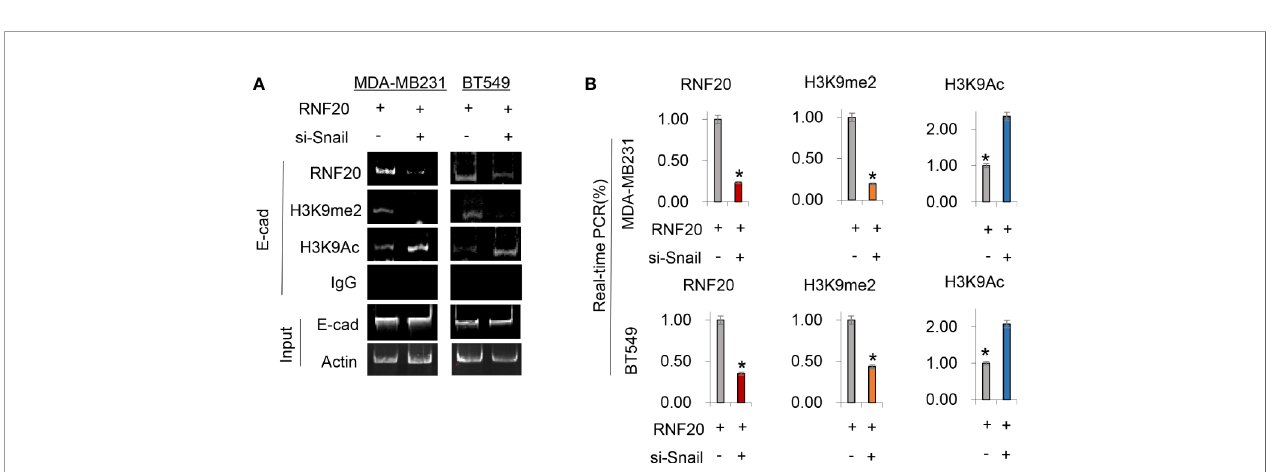
FIGURE 5 | RNF20 is recruited to the E-cadherin promoter for epigenetic silencing of E-cadherin expression by Snail. (A, B) RNF20 was expressed in MDA-MB231 and BT549 cells, and RNF20, H3K9me2, and H3K9 acetylation at the E-cadherin promoter were analyzed by the ChIP assay. Quantitative real-time PCR was also performed to analyze ChIP samples in (A) (mean ± SD from three separate experiments). *P < 0.01 by Student ’ s t test.